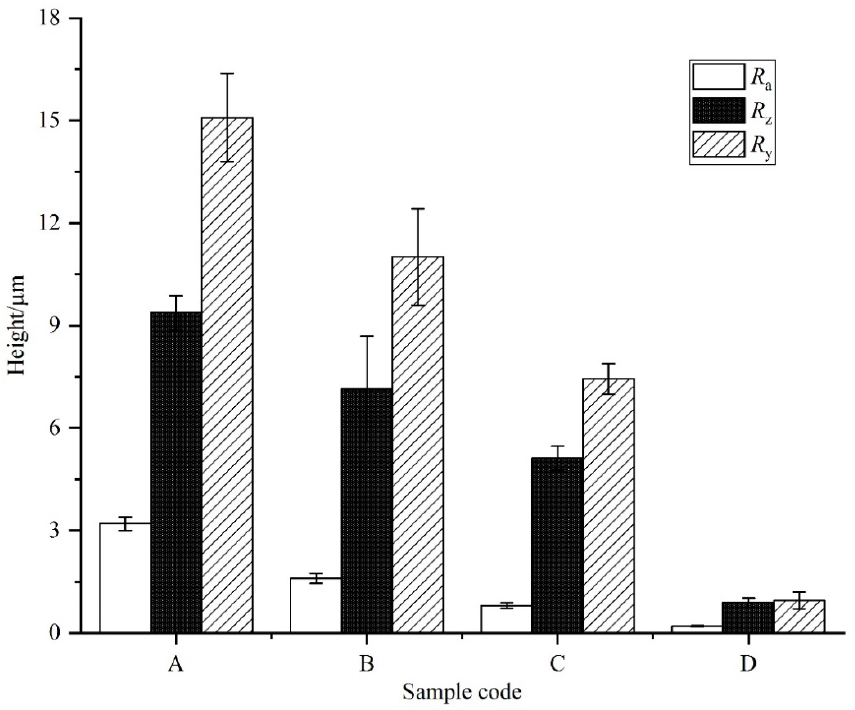
Figure 3. The two-dimensional roughness parameters of substrate samples.